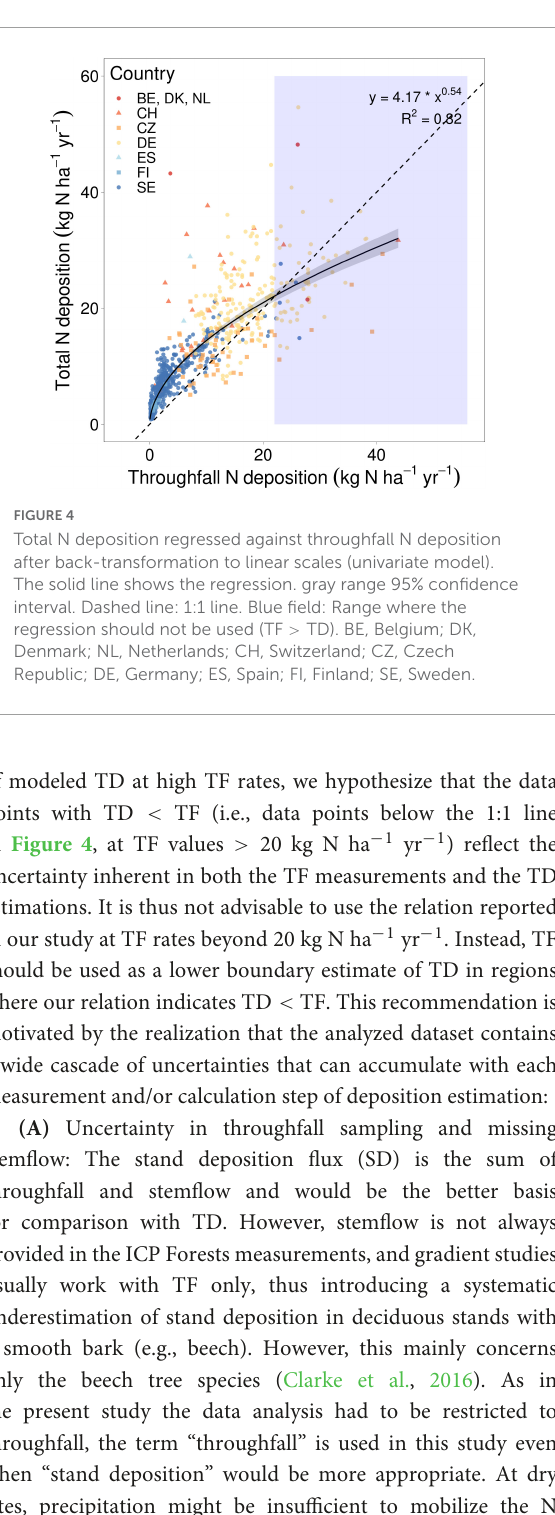
FIGURE3 Output of the univariate model: raw data plot and regression with 95%-confidence intervals as gray fields. Points are semi-transparent, so darker dots indicate overlap of several points.